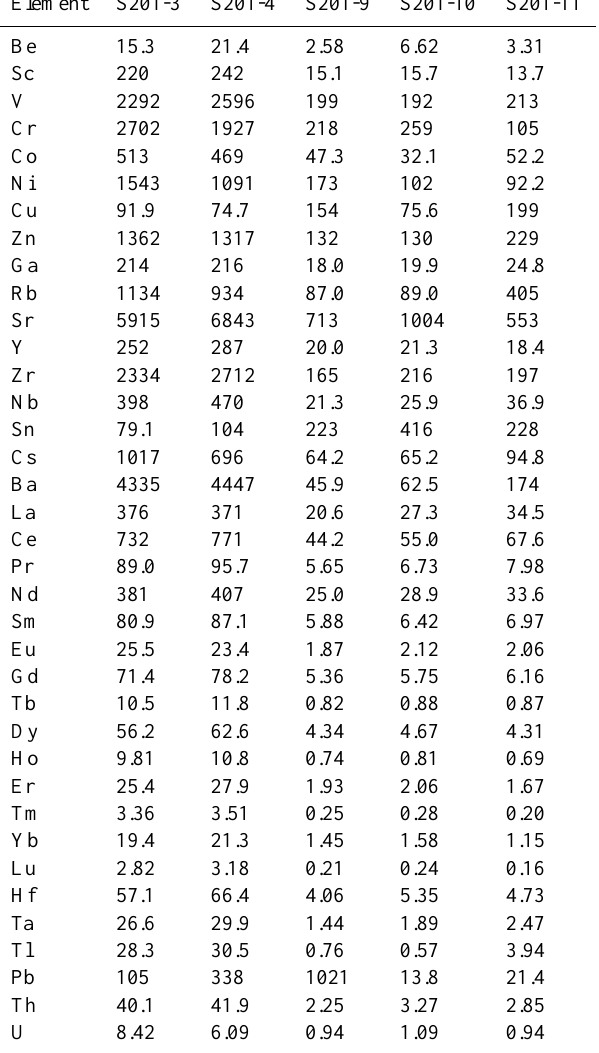
Table 4. Concentrations (10 − 9 ) of the trace elements from the basalt